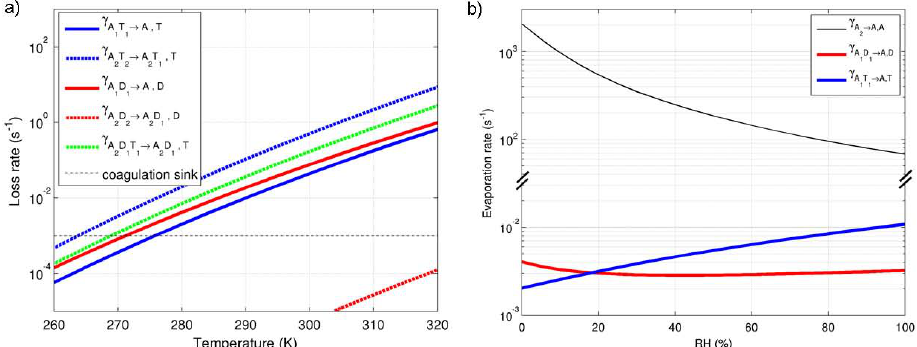
Fig. 1. (a) Evaporation rates from A 1 B 1 , A 2 B 2 and A 2 B 1 -clusters as a function of temperature at RH = 0. The presented evaporation rates are the highest rates corresponding to each cluster (see Table 2). The coagulation rate used in the model is depicted for comparison. (b) Effective evaporation rates from A 2 and A 1 B 1 -clusters at their equilibrium hydrate distributions as a function of RH at T = 280 K. Note the splitting of the